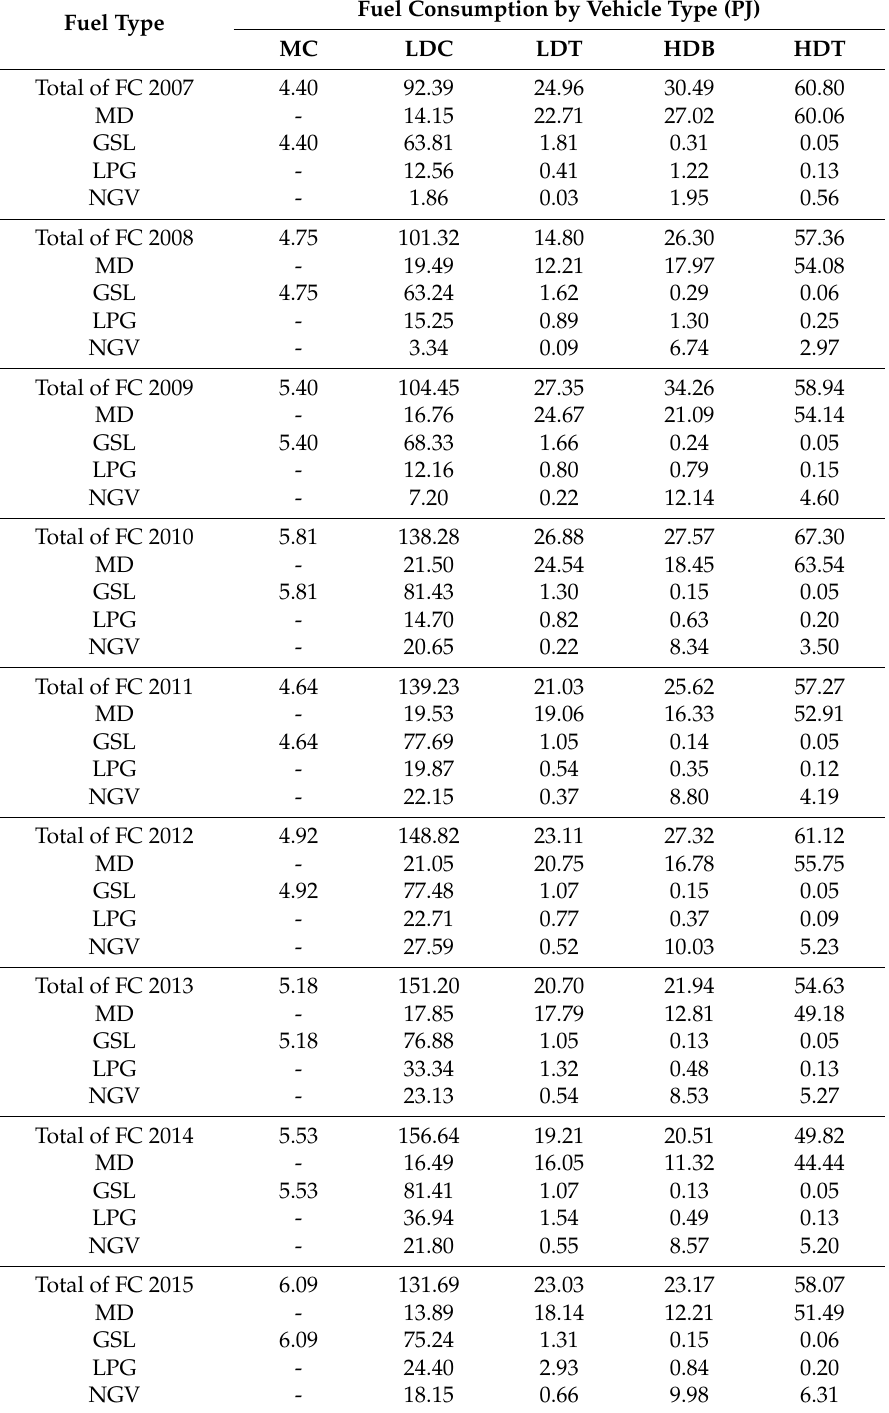
Table 2. Amount of fuel consumption classified by vehicle and fuel